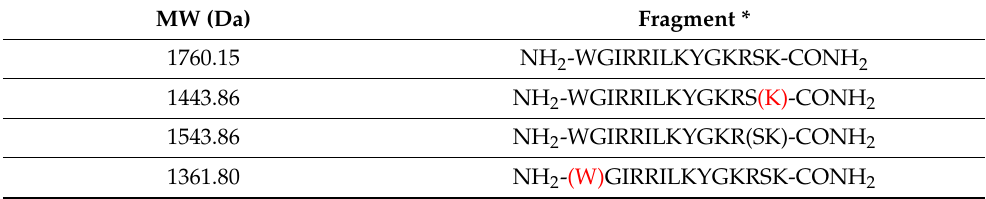
Figure 1. The representative RP-HPLC chromatograms of WMR at different times (0, 1, 3, and 5 h), and the percentage of intact peptide after incubation with 50% bovine serum at 37 °C. Table 1. Identification of serum proteolytic degradation fragments of the peptide WMR.